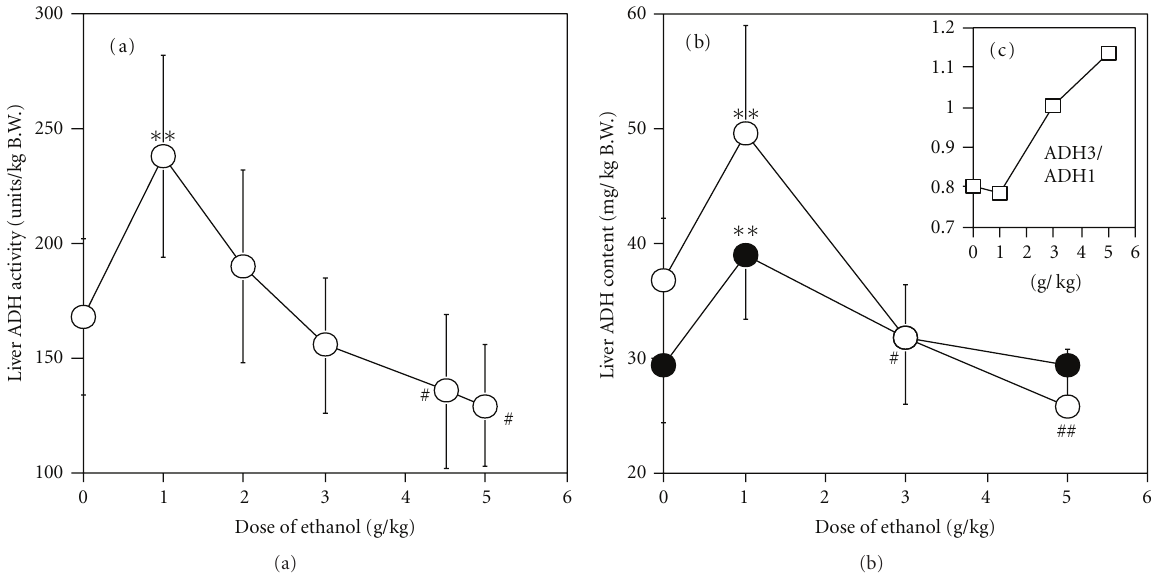
Figure 3: (a) E ff ect of ethanol dose on liver ADH activity. Three mice were sacrificed at scheduled times during ethanol metabolism after various doses of ethanol: 0.5, 1, and 2h for 1 and 2 g/kg (9 mice in each dose); 0.5, 1, 2, 4, and 8 h for 3 g/kg (15 mice in the dose); 0.5, 1. 2, 4, 8, and 12h for 0, 4.5, and 5.0 g/kg (18 mice in each dose), and livers were then removed to prepare liver extracts. The liver ADH activity was measured by the conventional assay with 15 mM ethanol as a substrate at pH 10.7 using liver extracts and is expressed in terms of liver weight/kg body weight. The activities were averaged in each group of ethanol dose to obtain the mean ± SD. (b) E ff ect of ethanol dose on ADH 1 ( (cid:2) ) and ADH 3 ( (cid:2) ) content of liver. In addition to liver ADH activity, the liver extracts were used to measure ADH isozyme contents by EIA using isozyme-specific antibodies. Liver ADH isozyme contents were also averaged in each group of ethanol dose to obtain the mean ± SD. (c) E ff ect of ethanol dose on ratio of ADH 3 content to ADH 1